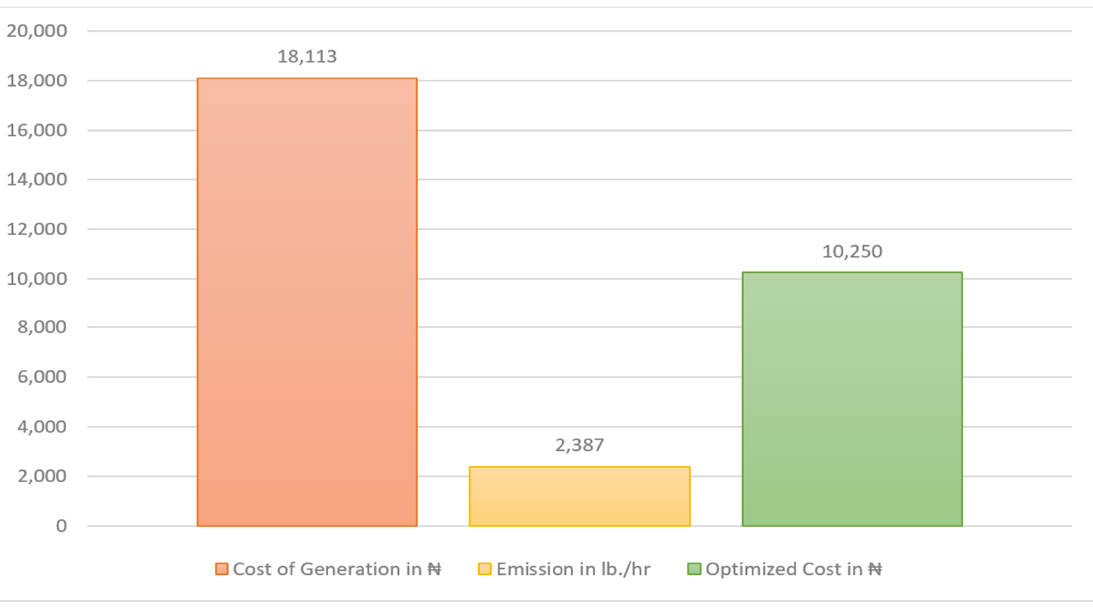
Table 7. Optimal power output for Case 4.